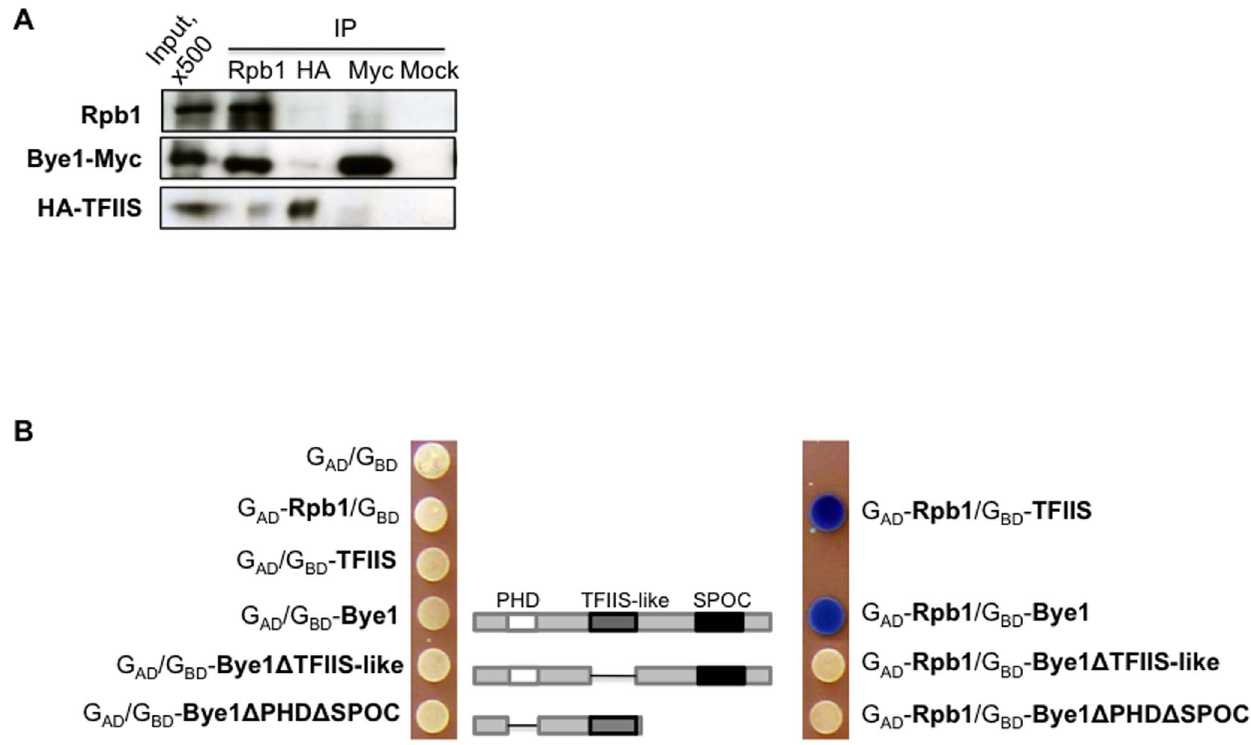
Figure 3. Bye1 is associated with the Pol II Rpb1 subunit invivo : (A) Co-immunoprecipitation of Bye1-Myc, HA-TFIIS and Rpb1 from cross-linked cellular extracts; (B) Bye1 and TFIIS interact with the jaw domain (aa 1154–1252) of Rpb1 by Y2H. All three domains, TFIIS- like, PHD and SPOC, are essential for Rpb1-Bye1 interaction: overlay of the Y190 strain transformed with either empty G AD /G BD vectors or G AD fused to the Rpb1 jaw domain and G BD fused to Bye1 or TFIIS. Left panel: control for the autoactivated b -galactosidase activity. Right panel: interactions are observed for Rpb1 and TFIIS and for Rpb1 and Bye1 the whole and the PHD and SPOC deleted proteins.